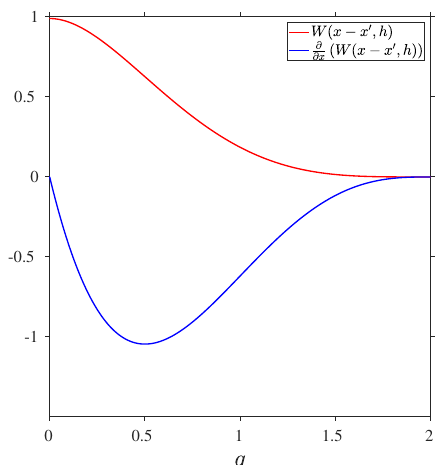
( W ( x − x (cid:48) , h )) according to Equations (13) ∂ x